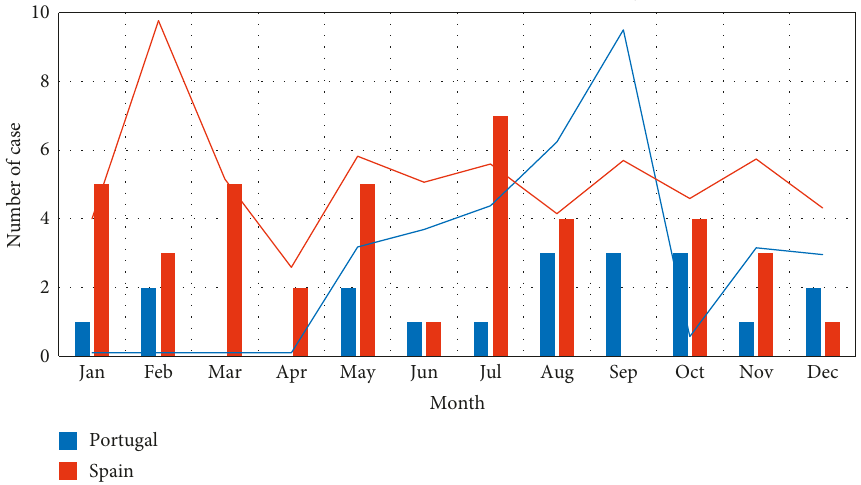
Figure 5: High incidence rate ConvLSTM model monthly forecast results chart (Portugal and